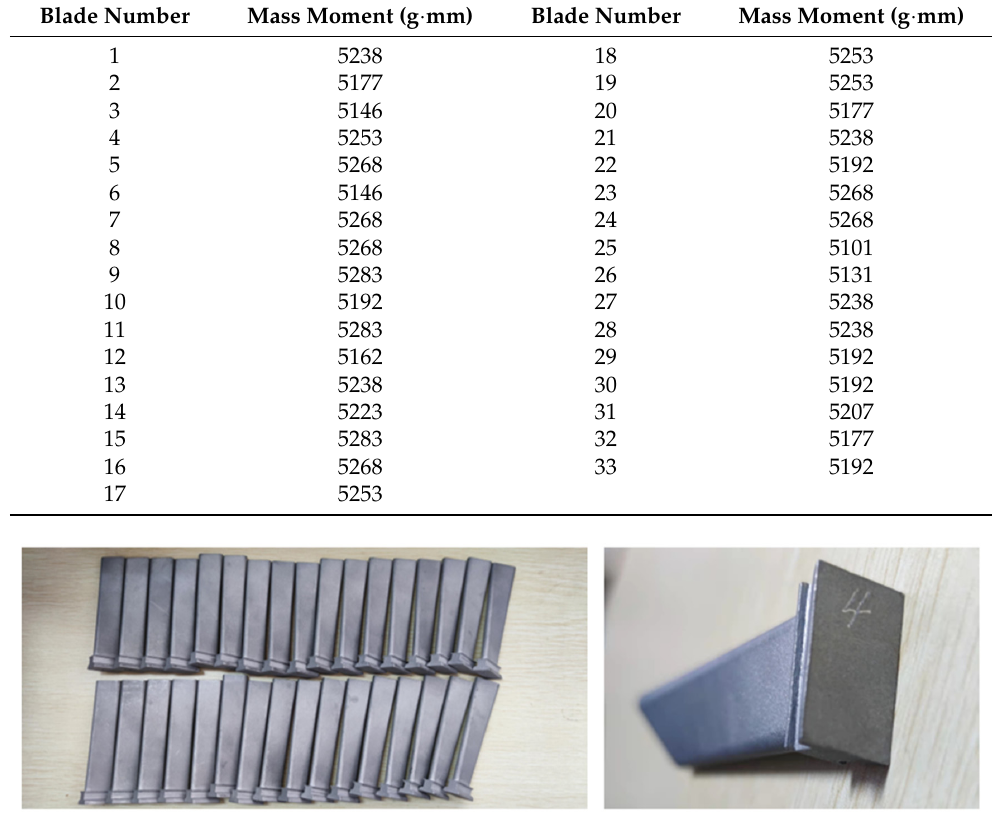
Figure 7. Schematic diagram of the blade.